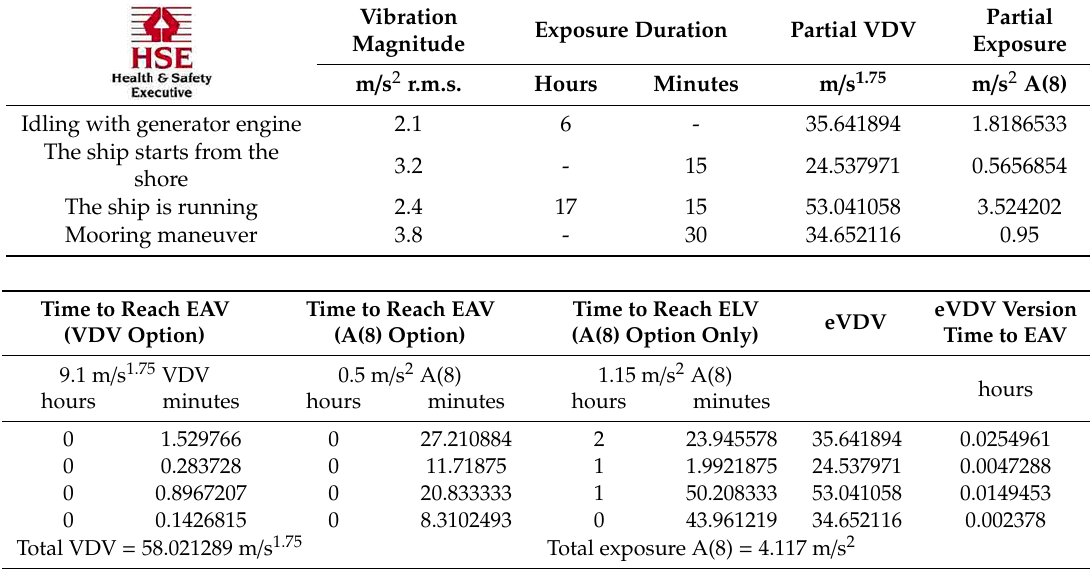
Table 3. Calculation of the average vibration-specific parameters transmitted to the three subjects during the period under discussion.